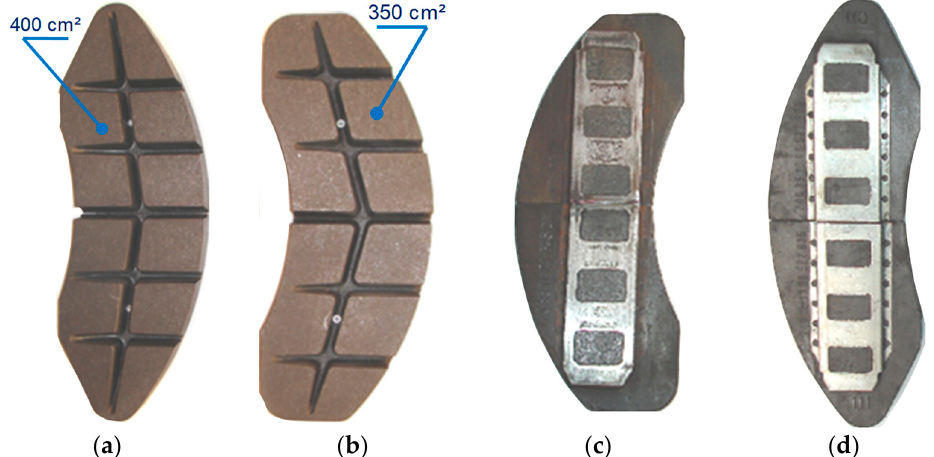
Figure 4. Friction pads used during the test: ( a ) type 350 view from disc contact side, ( b ) type 400 view from disc contact side, ( c ) type 350 view from clamping side with holder, ( d ) type 400 view from clamping side with holder.